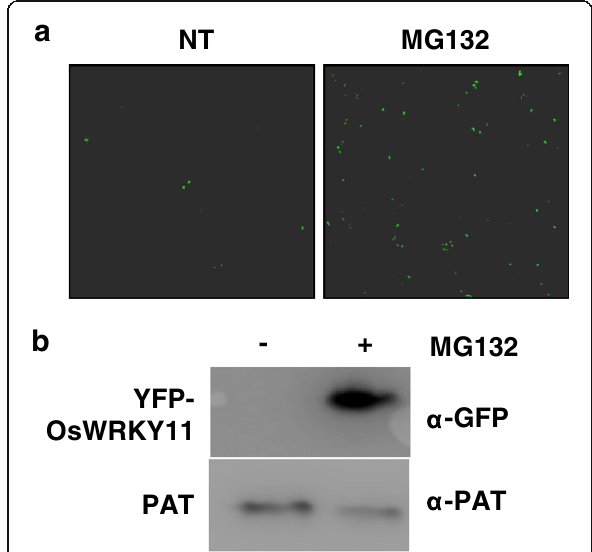
Fig. 7 Degradation of Os WRKY11 protein by the UPS. a Rice ( Oryza sativa ) protoplasts were transformed with 35S:: OsWRKY11-YFP . After 4 h, protoplasts were treated with 100 μ M MG132 and buffer for 1 day.